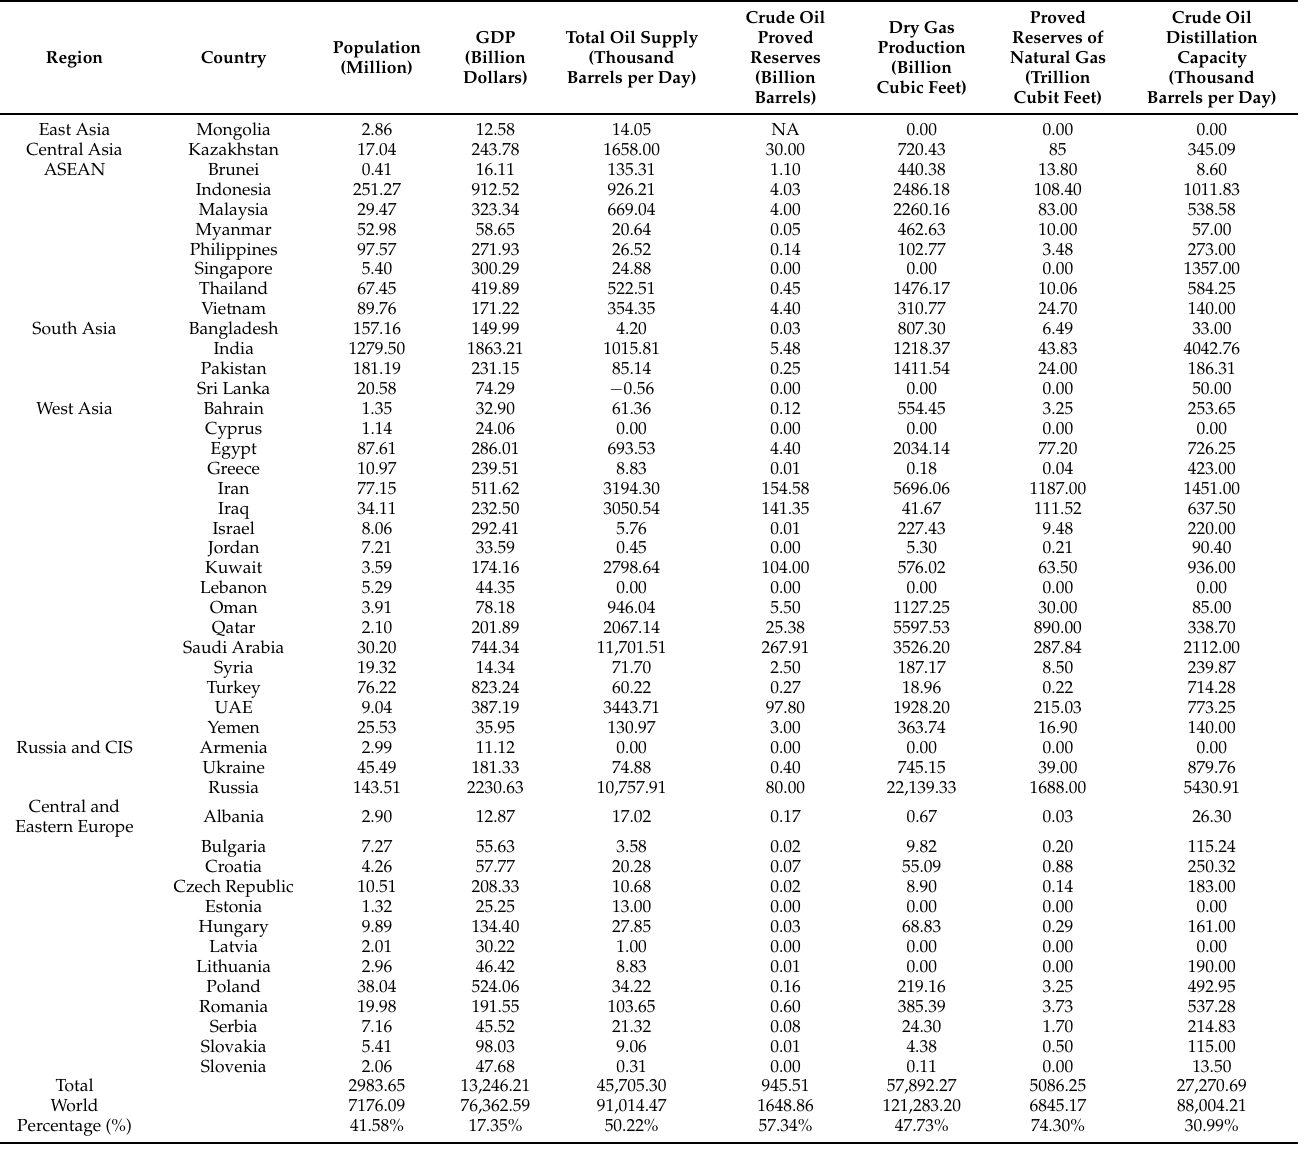
Table A1. Main statistics of 50 Nations alongside the China’s “Belt & Road Initiative in